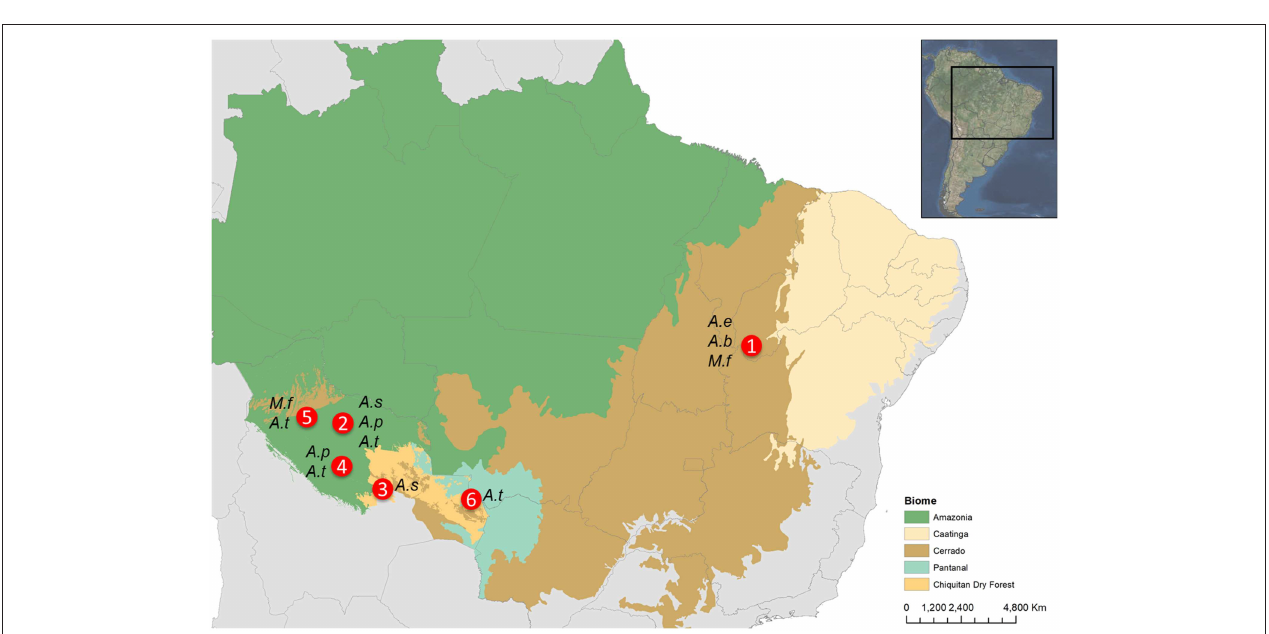
FIGURE 1 | Map indicating the location of the study areas (1: Sao Gonçalo da Gurguéia, Piaui, Brazil; 2: San Ramón, Mamoré, Bolivia; 3: Yotaú, Guarayos, Bolivia; 4: Loreto, Marbán, Bolivia; 5: Exaltación de la Santa Cruz, Yacuma, Bolivia; 6: San Matías, Ángel Sandoval, Bolivia) for each palm species: A.e , Attalea eichleri ; A.b , Attalea barreirensis ; A.s , Attalea speciosa ; A.p , Attalea princeps ; M.f , Mauritia flexuosa ; A.t , Acrocomia totai .